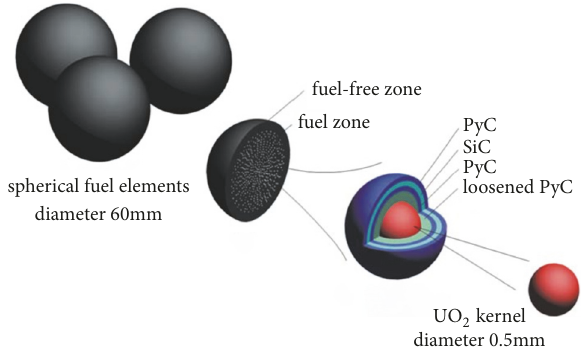
Figure 2: The structures of the fuel element and fuel